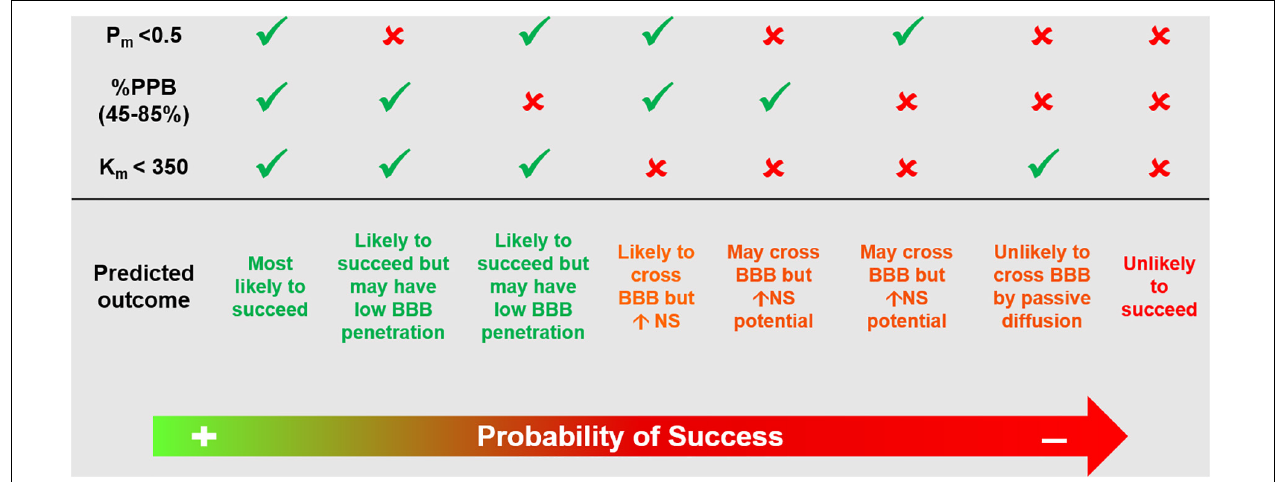
FIGURE 4 | Example of high performance liquid chromatography approach that could be used for screening and ranking of radiotracer candidates. Based on previously published methodology (Tavares et al., 2012b). This chromatography method uses compound retention time information to derive P m , %PPB and K m . These chromatography outcome measures can then be used to predict in vivo behavior of the compound using mathematical equations describing the relationships between chromatography outcome measures and in vivo measures (%injected dose in brain and binding potential BP ND ). P m , permeability; %PPB, %plasma protein binding to human serum albumin; K m , compound-membrane partition coefficient; BBB, blood brain barrier; NS, non-specific